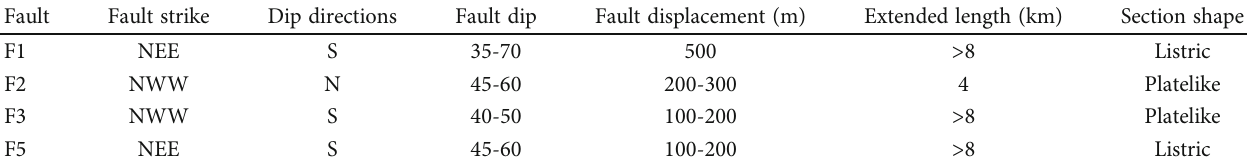
Table 3: Major fault elements of the eastern